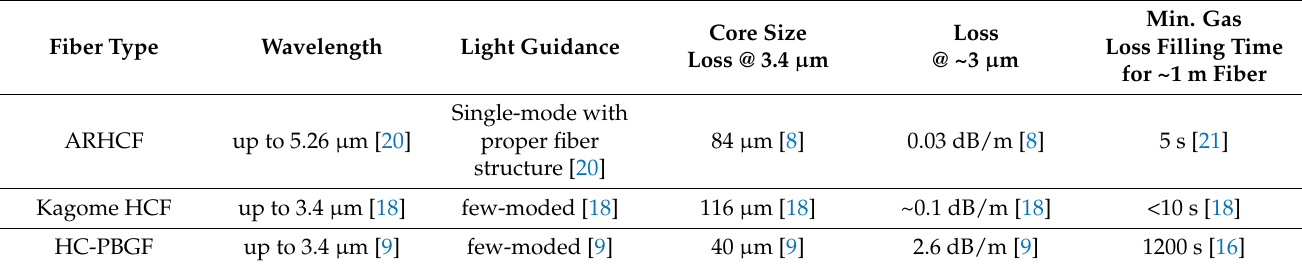
Table 1. Comparison of the performance of the HCFs used in gas sensing applications.